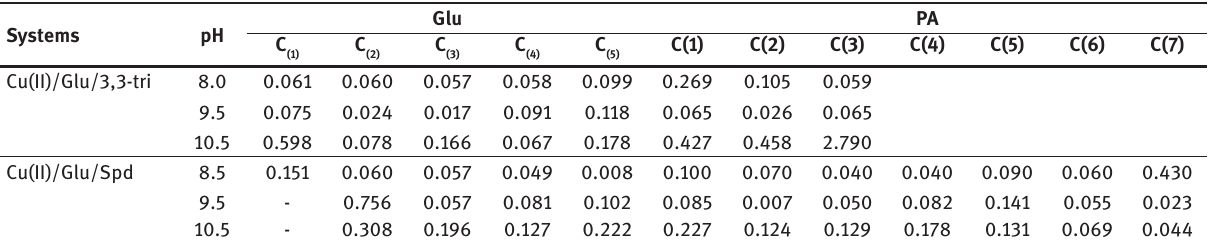
Table 5: Differences between 13 C NMR chemical shifts for the ligands in the Cu(II)/Glu/3,3- tri and Cu(II)/Glu/Spd systems in relation to the free ligands [ppm].